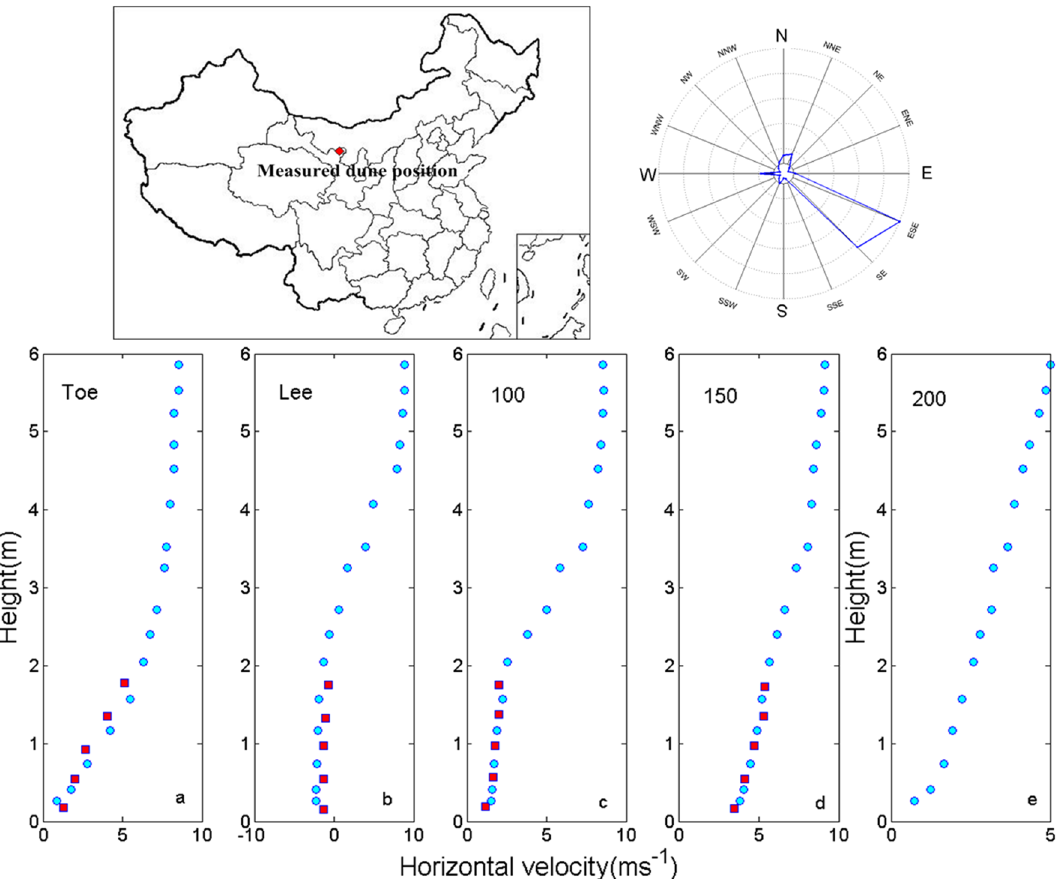
Figure 2. Comparison of simulation in wind field (round blue dots) and field measured wind velocity (square red blocks) at different locations of sand dune (the wind velocity position corresponded to the different distance position in Fig. 1b). The upper right corner showed the wind frequency map of the measured sand dune position. The map was plotted using Matlab 2014a (https ://www.mathw orks.com) and Surfer 16 (https ://www. golde nsoft